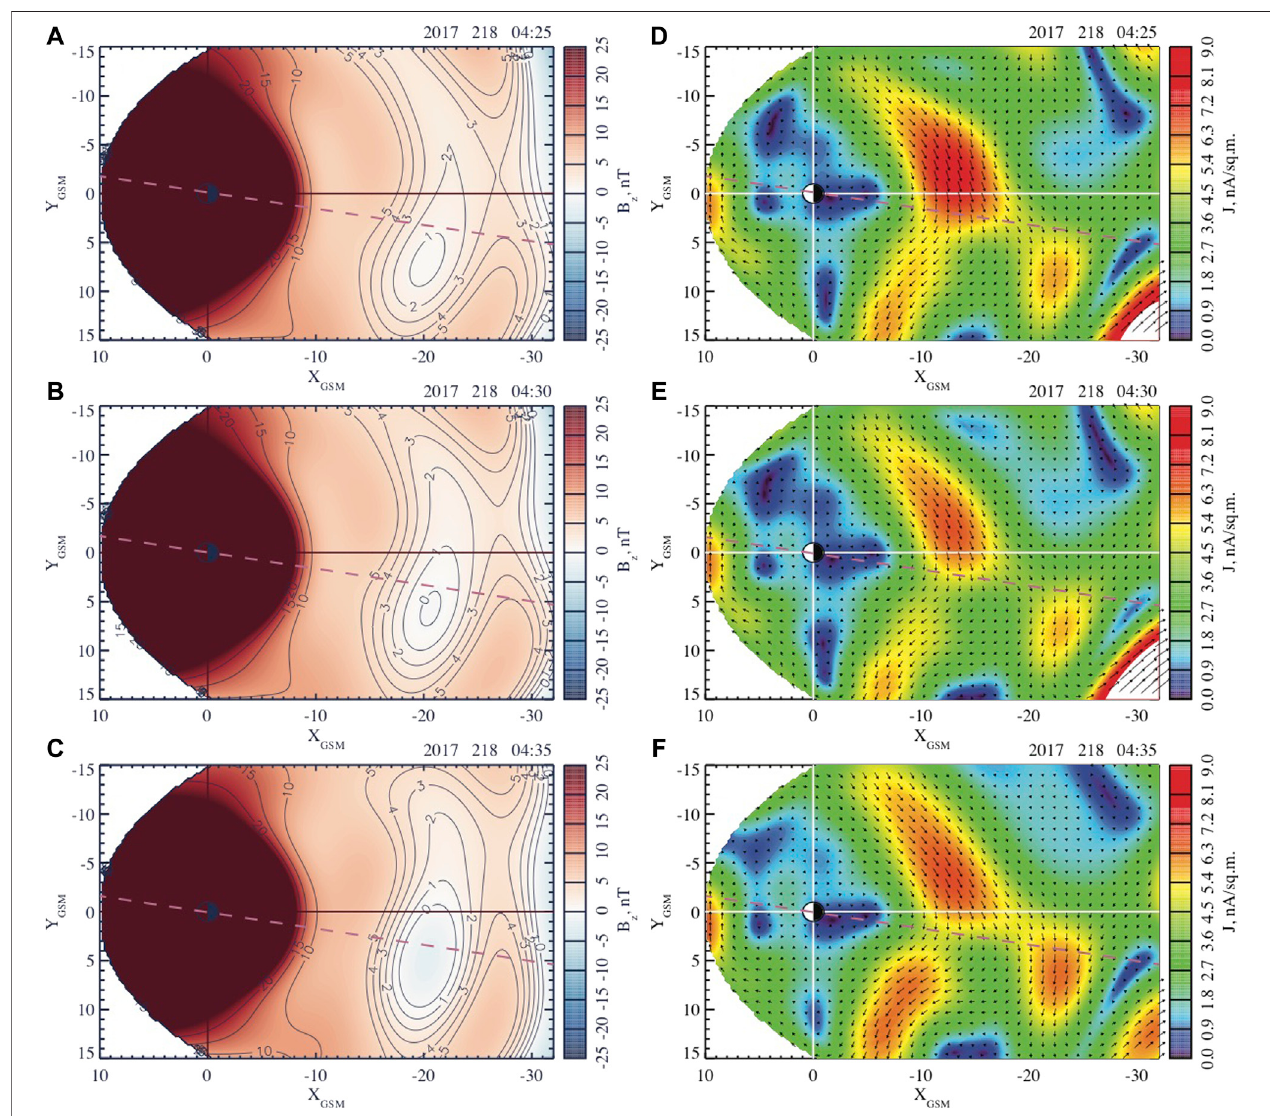
FIGURE6| Distributionsoftheequatorialmagnetic fi eld B z [ (A – C) ]andtheelectriccurrent[ (D – F) ]obtainedusing0-degreetiltangleforthe fi rstdipolarizationofthe 6 August 2017 substorm. The arrows are vectors of the equatorial current density whose absolute value is color coded. The oblique dashed pink lines show the meridional planes, which are used below to investigate this